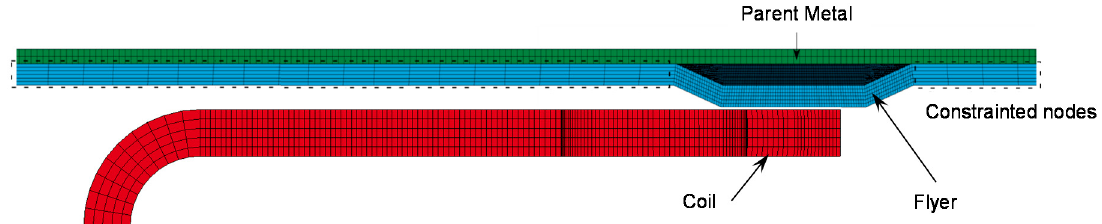
Figure 12. Model cross section view in the MPSW configuration with O shape coil